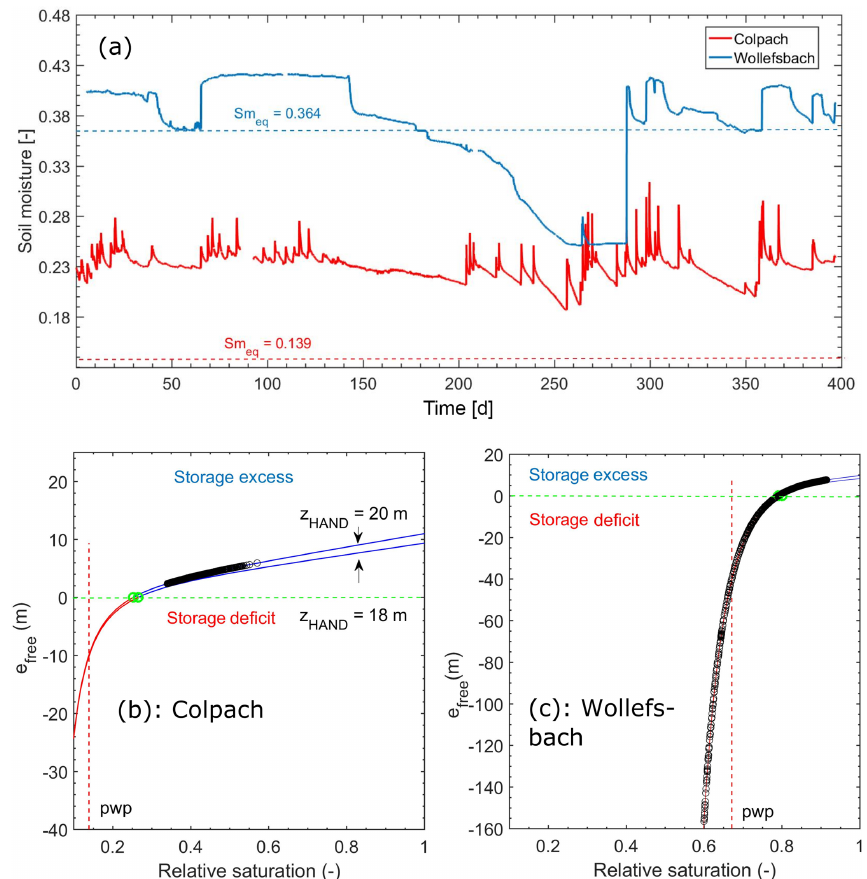
Figure 6. Top soil water content observed at cluster sites in the Colpach and Wollefsbach catchments (a) and the corresponding free energy states in their respective energy state curves ( b and c show the different scalings of the ordinates). The black circles mark the observations. The vertical dashed line marks the permanent wilting point. (b) and (c) show additionally the energy state curve when contaminating the real value of HAND with an error of − 2m ( z HAND = 18m). This is to highlight that an error in the estimated depth to groundwater implies a substantial mismatch between observations and the theoretically predicted